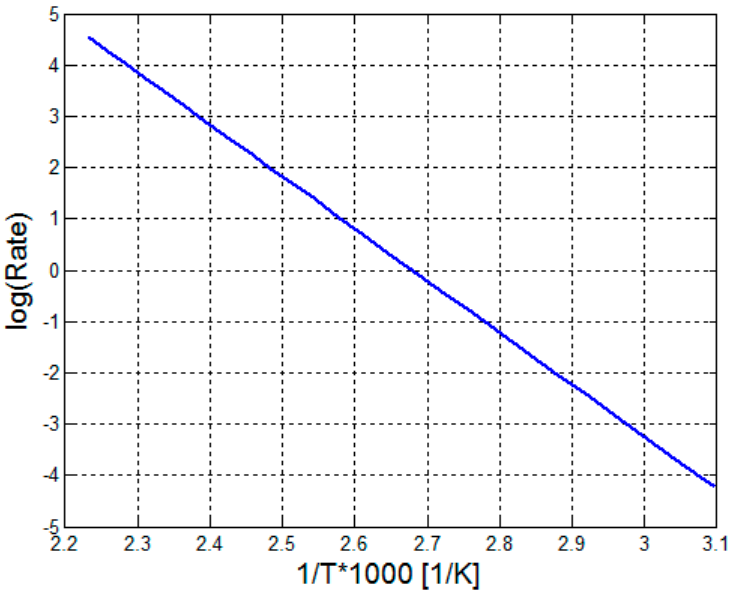
Figure 4. Arrhenius plot of the oleic acid and methanol conversion to FAME (biodiesel) and water.